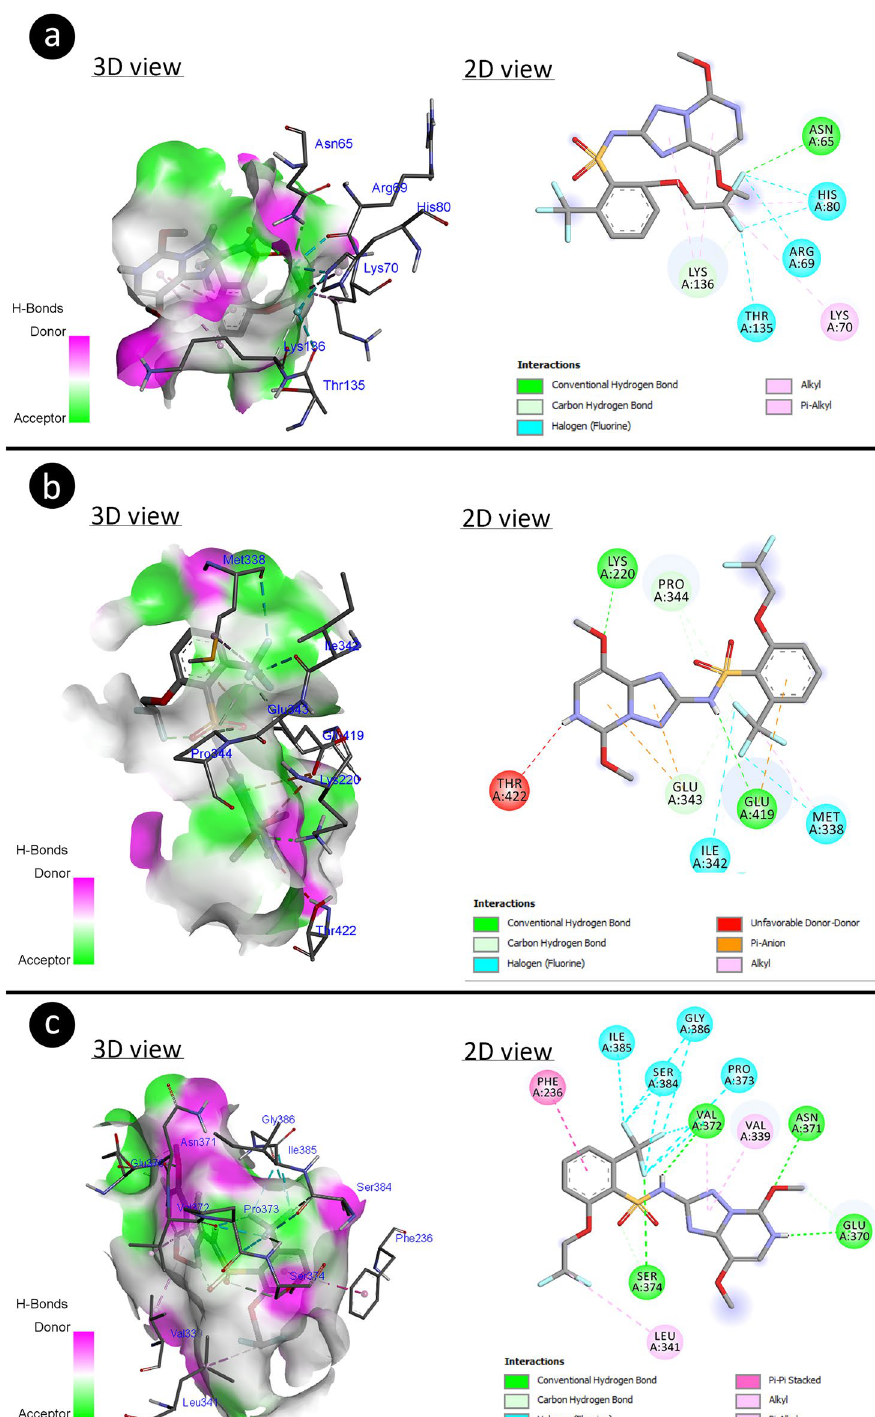
Figure 6. Molecular insights of penoxsulam interaction with antioxidant enzyme residues ( a SOD, b CAT, c